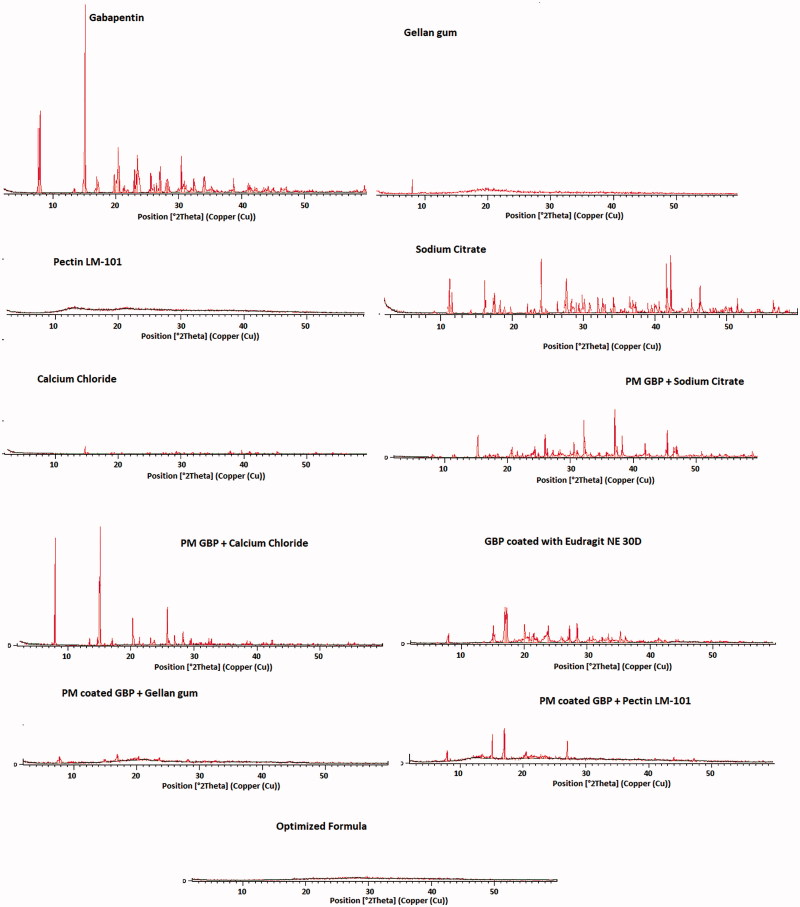
XRD diffractograms of GBP, physical mixtures, and optimized formula.